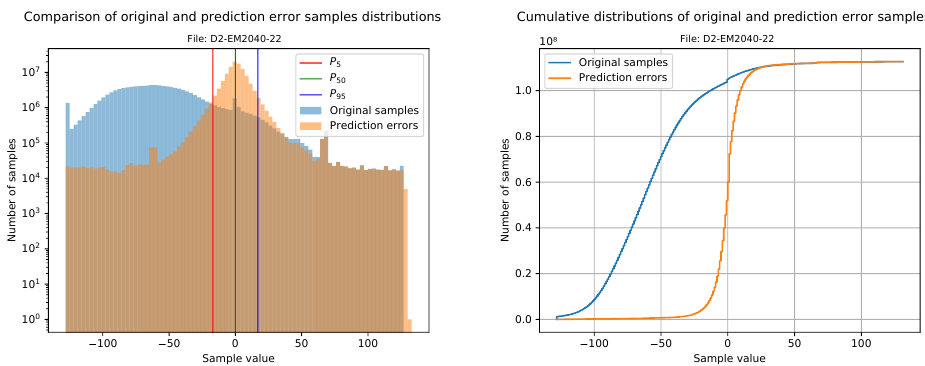
Figure 16. Histograms showing the range reduction in water column data from an EM2040.